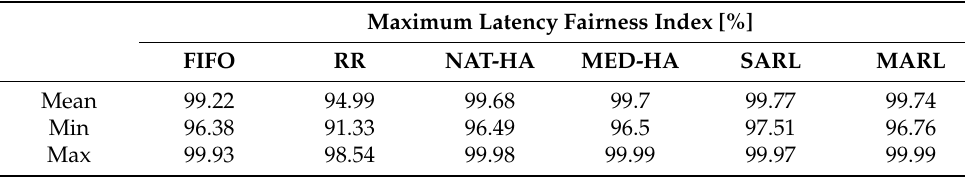
Table 14. Comparison of average maximum E2E latency by the scheduler.